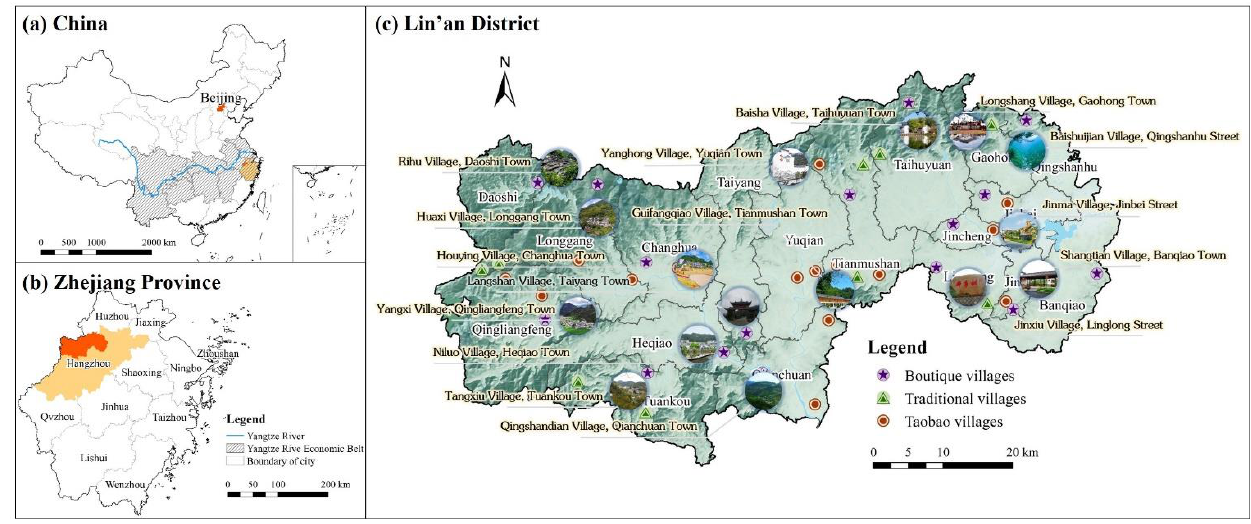
Figure 4. The study area of Lin’an District. ( a ) The location of Lin’an District in China. ( b ) The location of Lin’an District in Zhejiang Province. ( c ) Distribution of typical villages in Lin’an District.